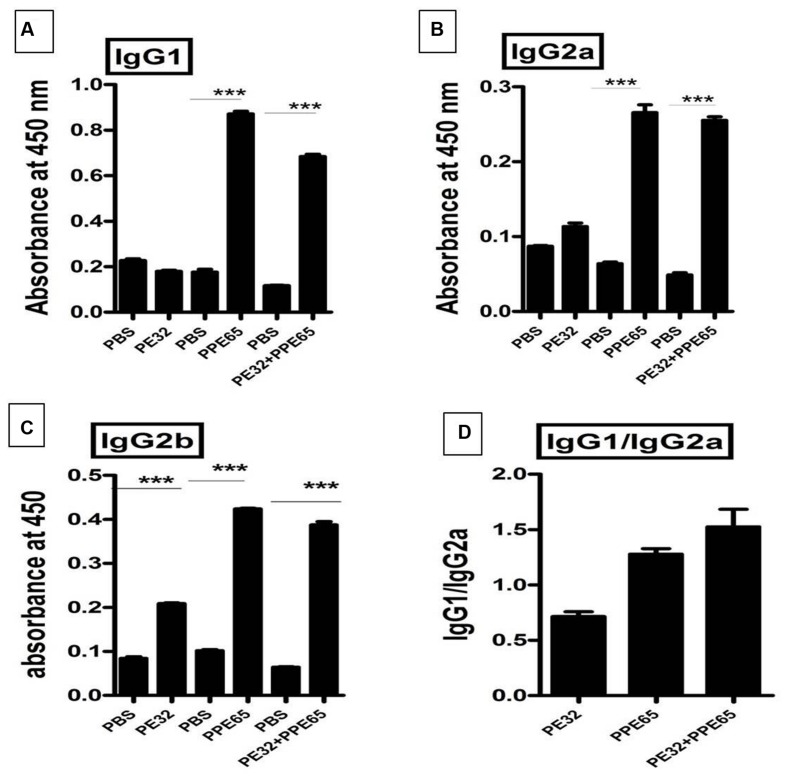
Antibody isotype analysis reveals the skewing of immune phenotype toward Th2 type of response. Sera from immunized mice were used to perform ELISA to measure IgG1, IgG2a, and IgG2b. (A) Mice immunized with PE32 show low IgG1 while those immunized with PPE65 and PE32 + PPE65 proteins showed higher levels of IgG1 against respective proteins. (B,C) Similar observation was made for IgG2a and IgG2b. IgG1 vs. IgG2a ratio is important to determine whether the response is Th1 or Th2. (D) The IgG1/IgG2a >1 shows Th2 response for PPE65 and PE32 + PPE65. Error bar represents SEM of average of three animals in biological triplicates. ∗∗∗p < 0.001.